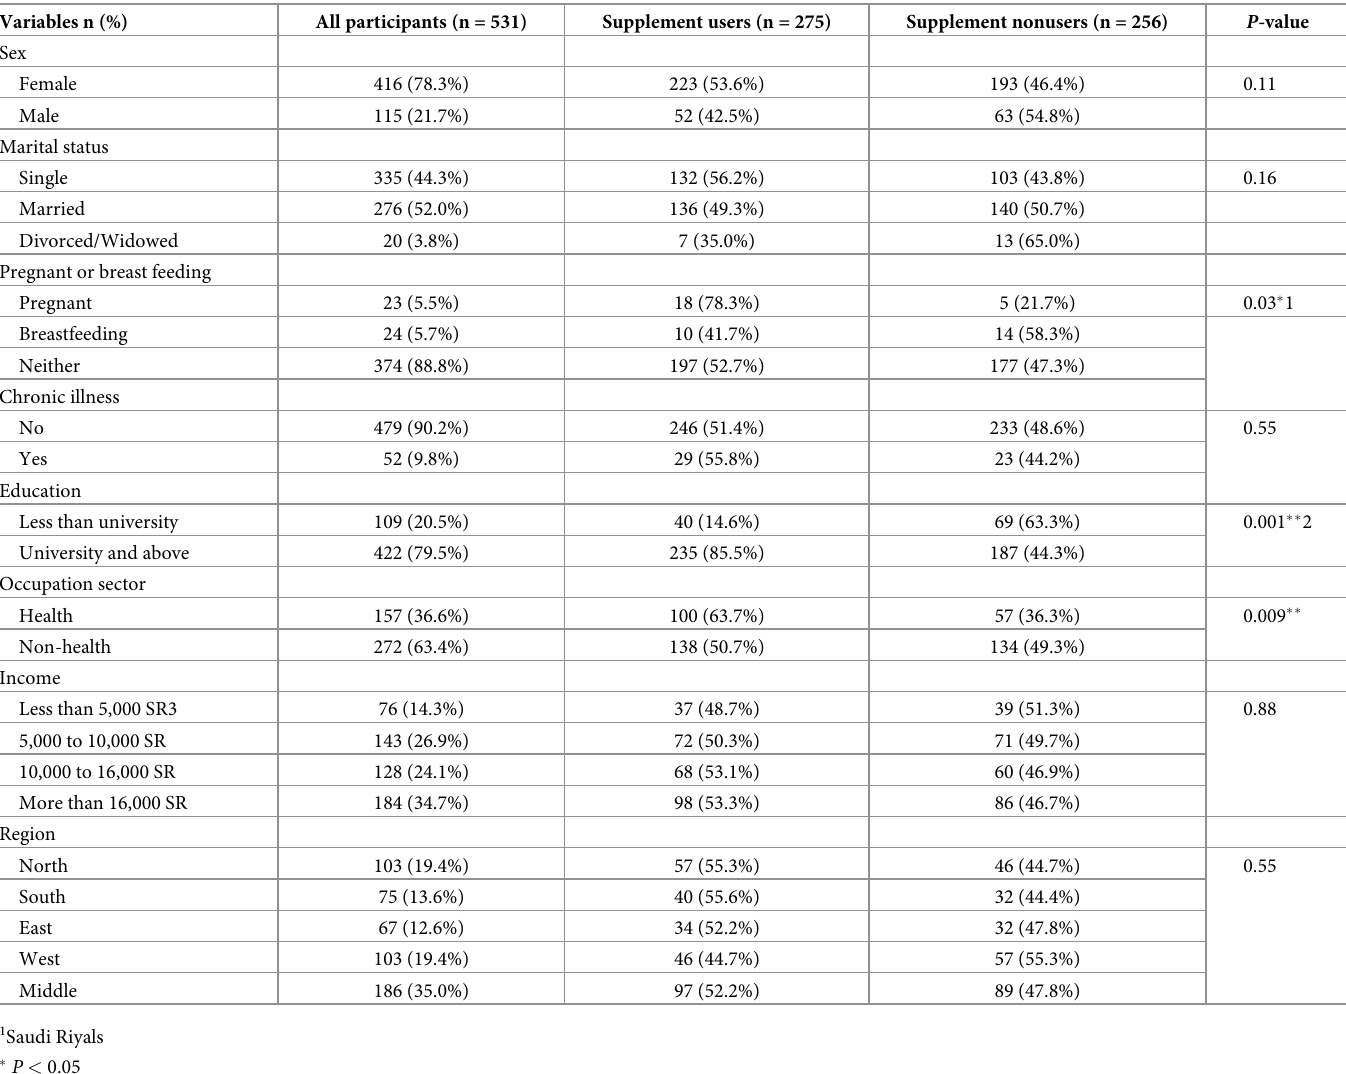
Table 1. Frequencies and percentages of sociodemographic variables by dietary supplement use (n = 531). Variables n (%) All participants (n =